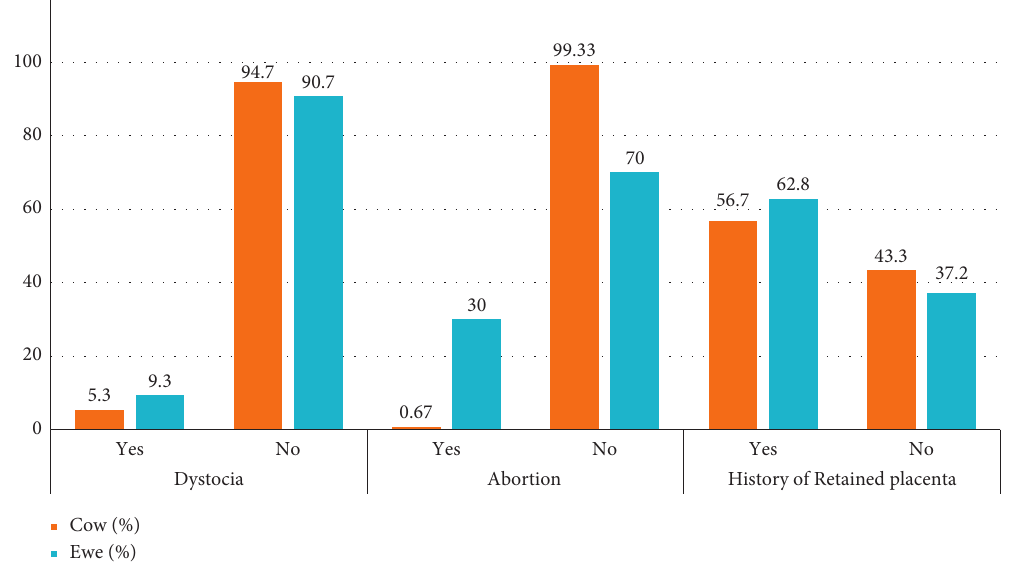
Figure 2: Proportion of different reproductive health problems in cow and ewe in the study